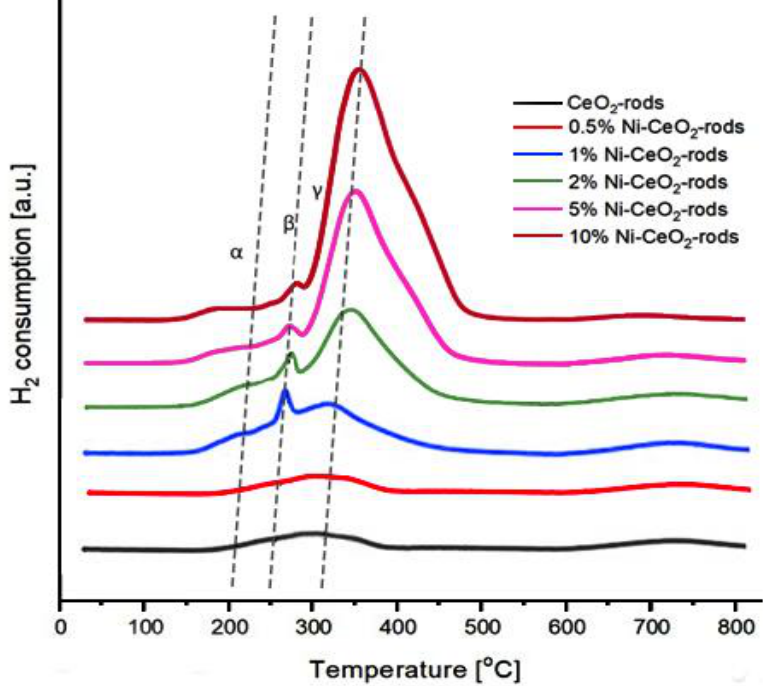
Figure 13. H 2 -TPR profiles of Ni-CeO 2 rods catalysts.